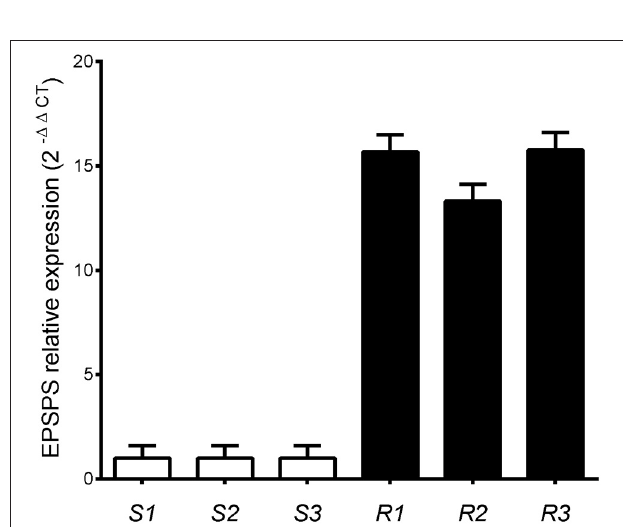
FIGURE 4 | Relative EPSPS expression in glyphosate-susceptible (S) and -resistant (R) plants of Lolium perenne plants, using the cinnamoyl-CoA reductase gene for normalization. Vertical bars represent ± 1 standard error of the